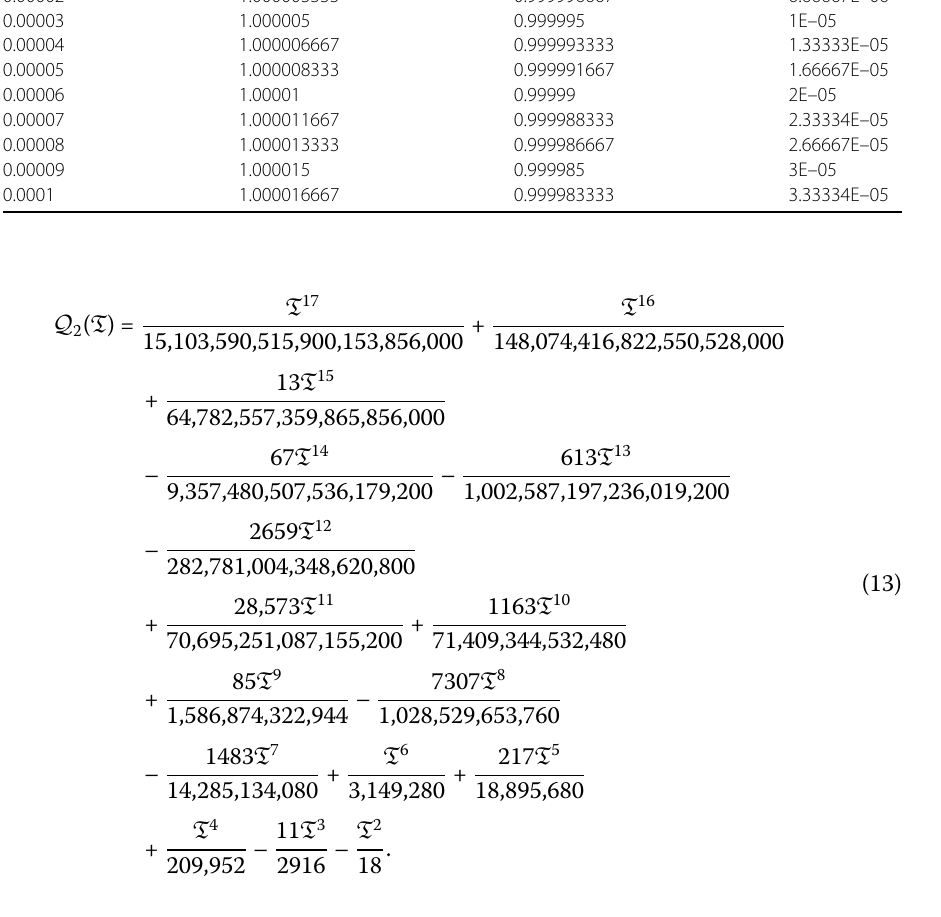
Table 1 Numerical values of the solutions through the AD method Value of T Computational Semi-analytical Absolute error